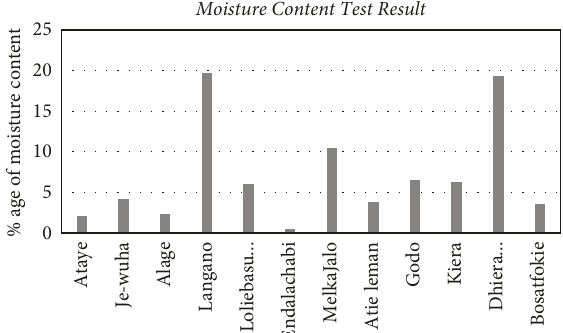
Figure 4: Moisture content (source: during study).